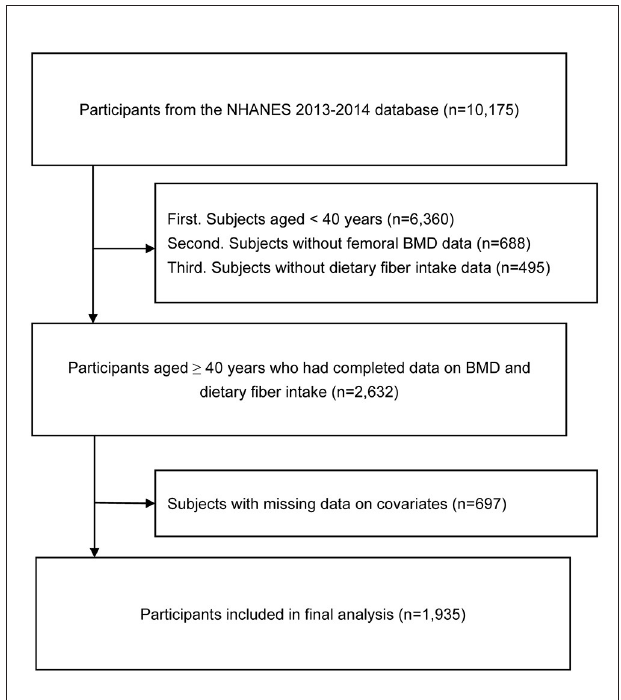
FIGURE 1 | Flow chart of participant selection. NHANES, National Health and Nutrition Examination Survey; BMD, bone mineral